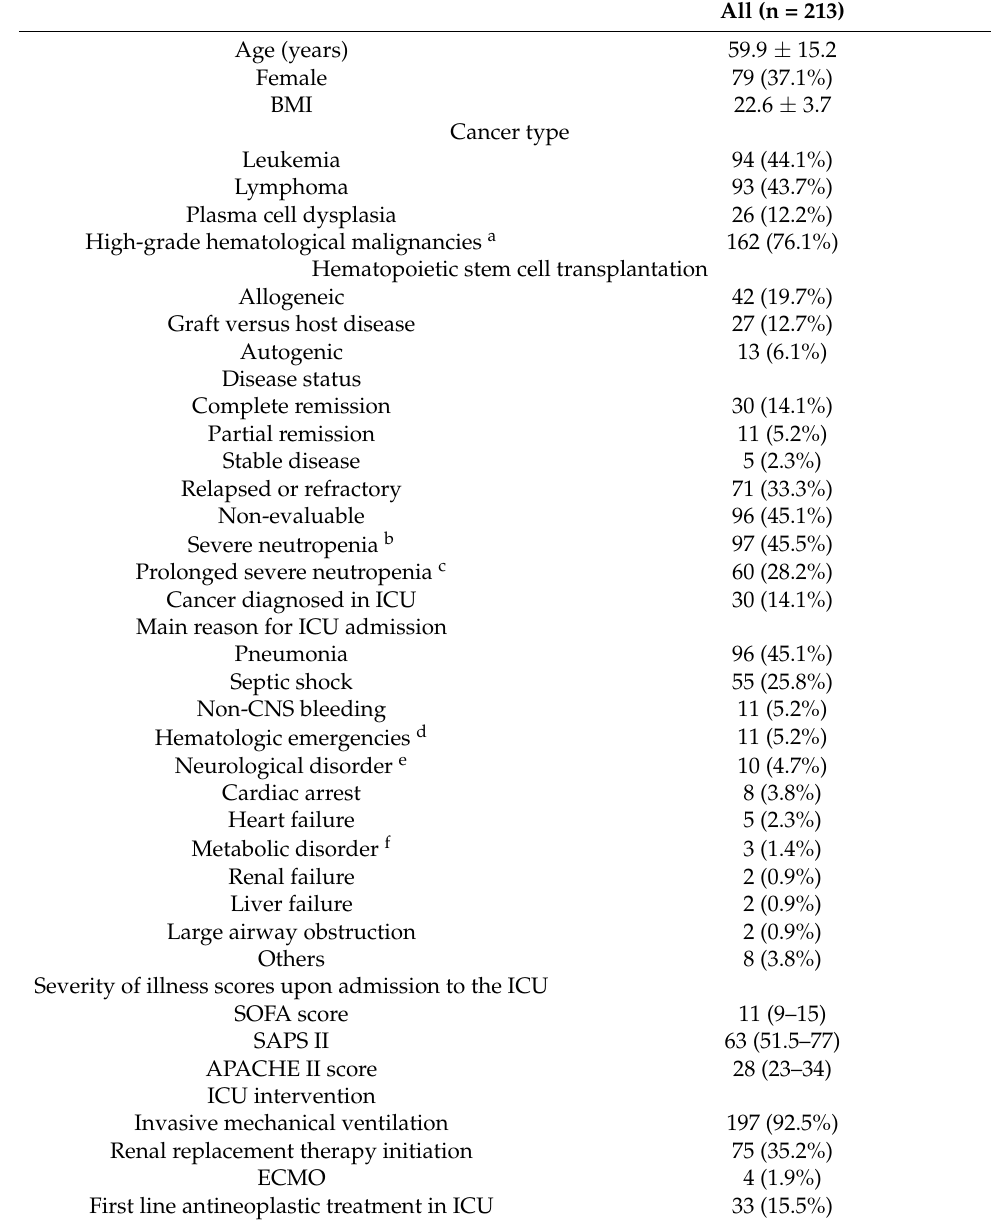
Table 1. Patient